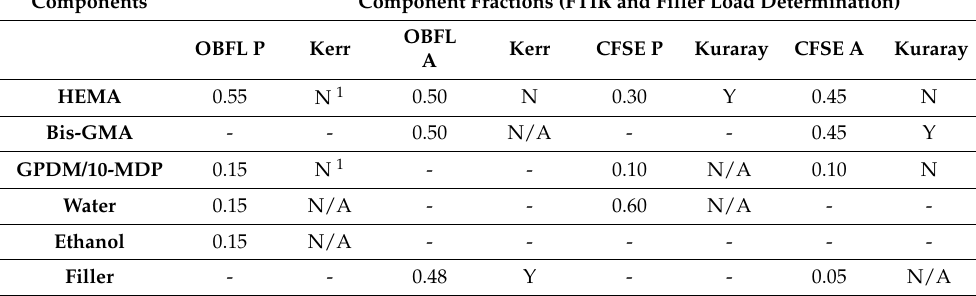
Table 6. Table comparing fractions found in this study to fractions supplied in the safety datasheets and information derived from suppliers (retrieved from Table 1). Y (yes) indicates the fractions were within the range reported by the manufacturer, N (no) indicates they fell outside the range, while N/A (not available) was added when there was no information